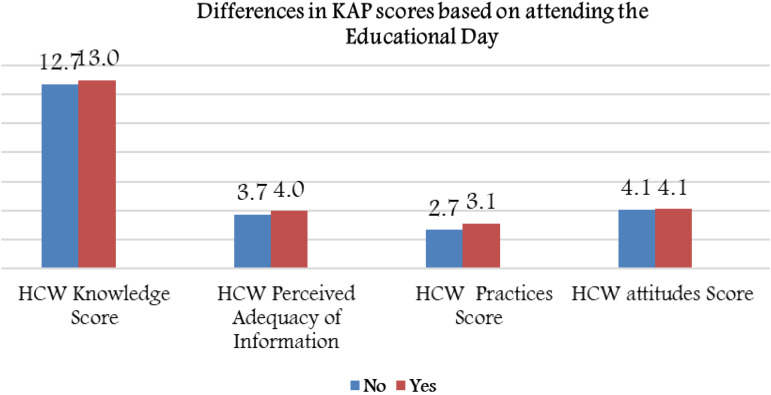
Mean KAP scores and perceived adequacy of information based on attendance at the Educational Day conference.